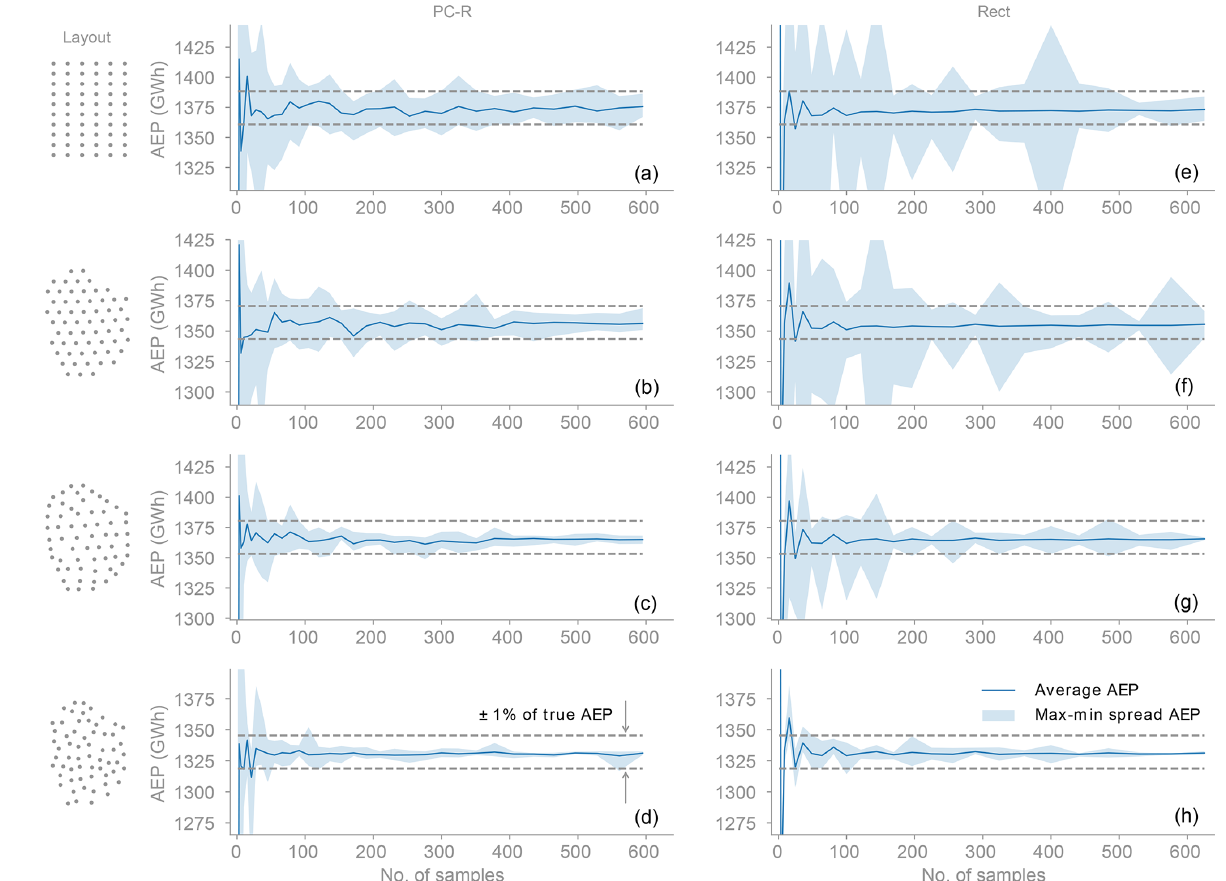
Figure 9. Variability in the convergence of the AEP. Panels (a) – (d) are for polynomial chaos based on regression and panels (e) – (h) for the rectangle rule. The shaded area shows the spread between the maximum and minimum AEP for 10 realizations of each of the number of samples. The range in the plots corresponds to ± 5% of the true AEP for each layout. The variability is significantly smaller for polynomial chaos, which shows that in general it outperforms the rectangle rule. The PC-R method obtains smaller variability by smoothing out the high-frequency oscillations present in the power response (Fig.